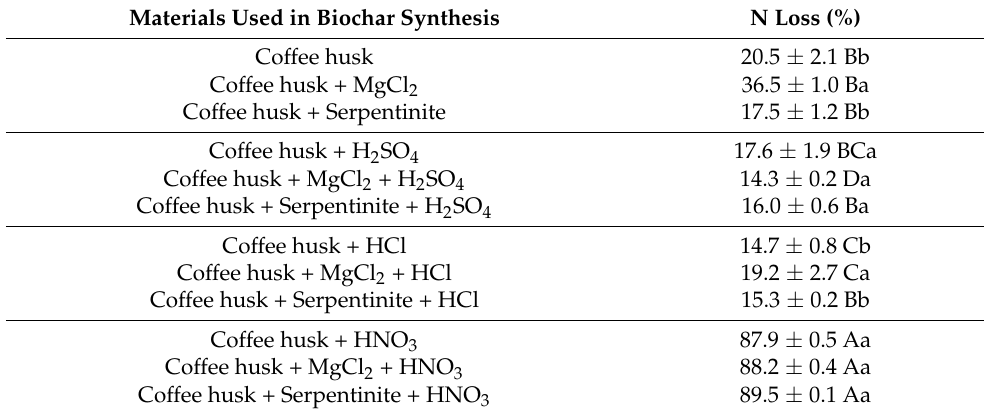
Table A2. Nitrogen losses during pyrolysis and biochar-based fertilizers production.